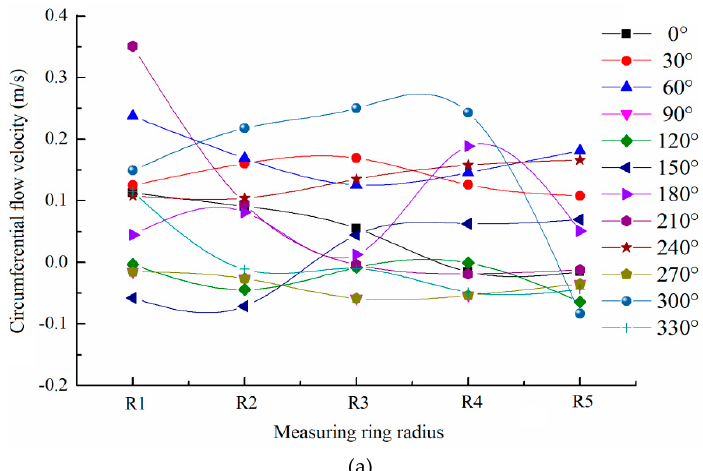
Figure 14. Circumferential flow velocity distribution of annular gap sections of the capsules: ( a ) L / d = 2.5, rear section; ( b ) L / d = 2.5, middle section; ( c ) L / d = 2.5, front section; ( d ) L / d = 2.14, rear section; ( e ) L / d = 2.14, middle section; and ( f ) L / d = 2.14, front